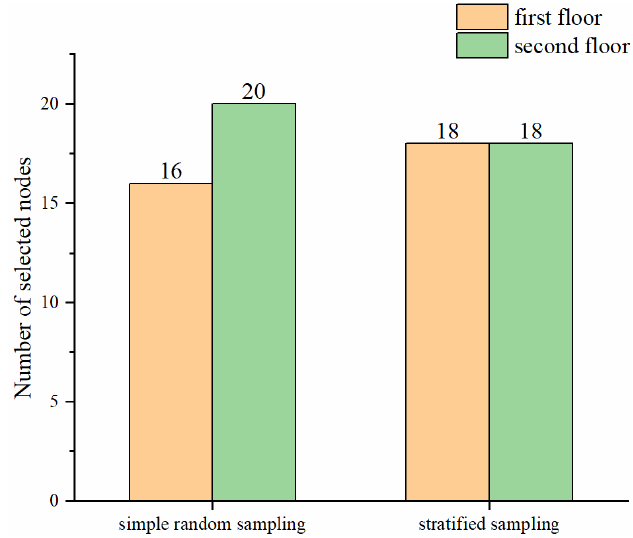
Figure 15. Sampling result.